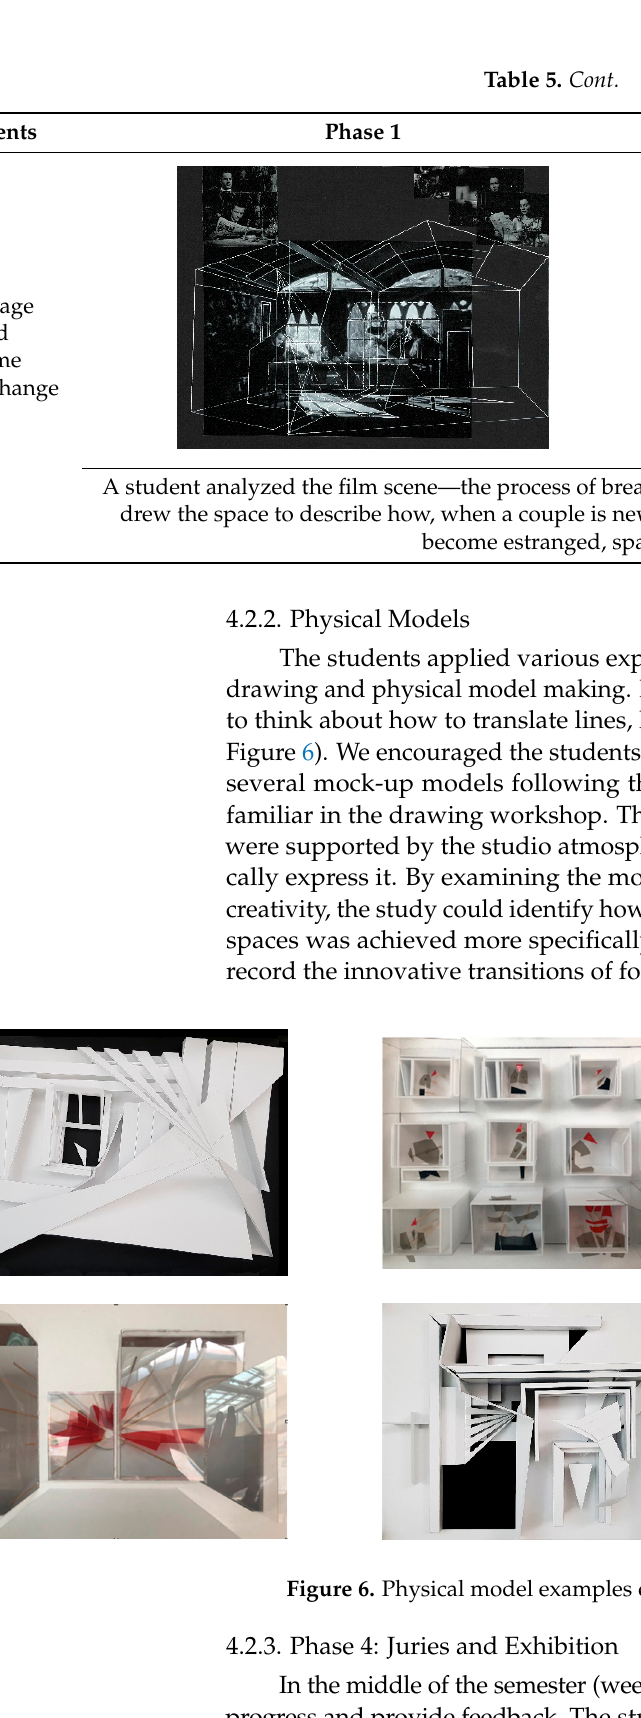
Buildings 2021 , 11 , x 16 of 21 Table 5. Student representations of filmic elements. Elements Phase 1 Phase 2 Movement and Frame